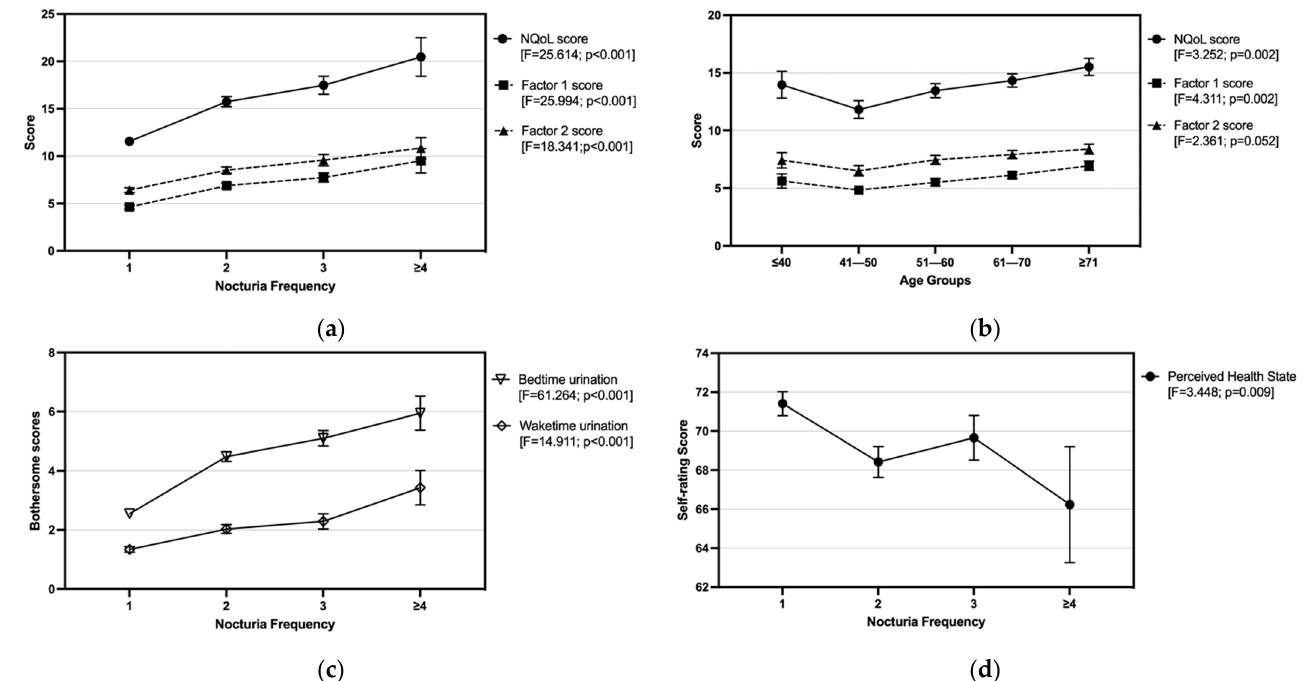
Figure 3. Nocturia-related QoL, bothersome caused by nocturia, and health state perceived by the individuals with nocturia, are presented as the trends of: ( a ) NQoL score and factor scores against the increasing nocturia frequency, and ( b ) against the advancing age groups, and ( c ) the bothersome score and ( d ) the health state score against the increasing nocturia frequency.